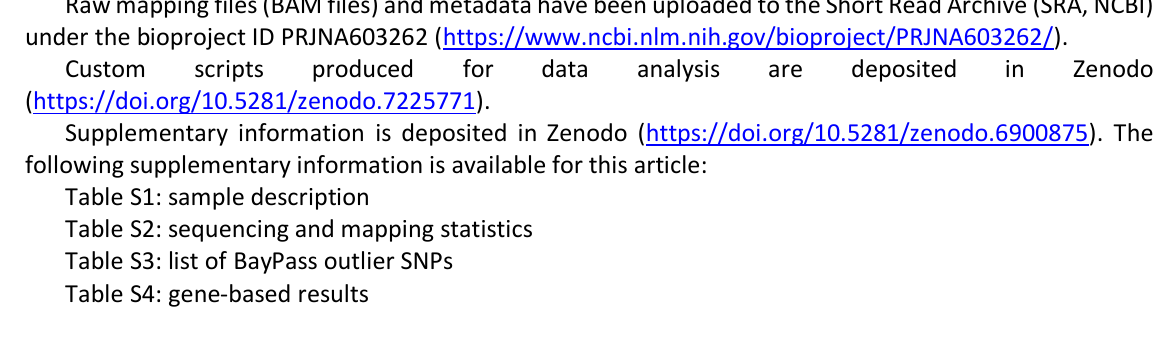
Table S1: sample description Table S2: sequencing and mapping statistics Table S3: list of BayPass outlier SNPs Table S4: gene-based